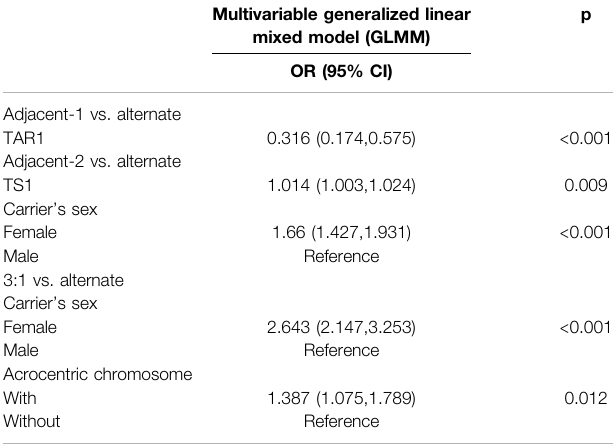
TABLE 4 | Multivariable generalized linear mixed model analysis. Multivariable generalized linear mixed model